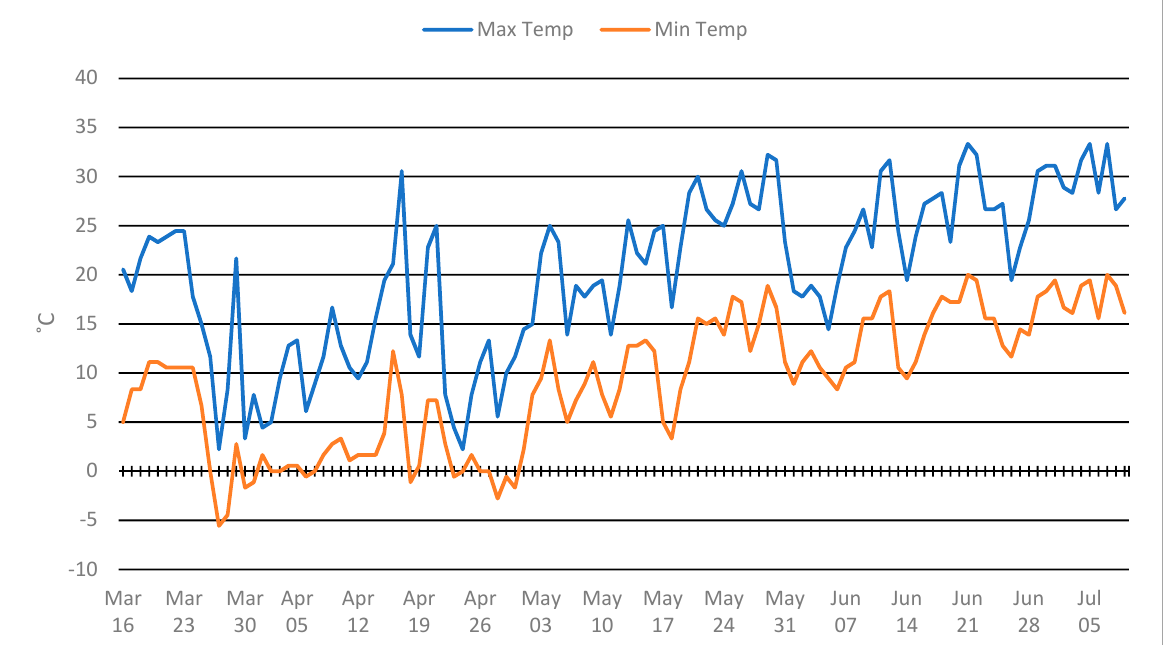
Figure 3. Minimum and maximum daily temperatures in Trial 1 from the removal of straw winter protection (16 March 16 2013) through the end of harvest (9 July 2014) harvest in Trial 1 of five short-day strawberry varieties in a cold climate region (central NY).